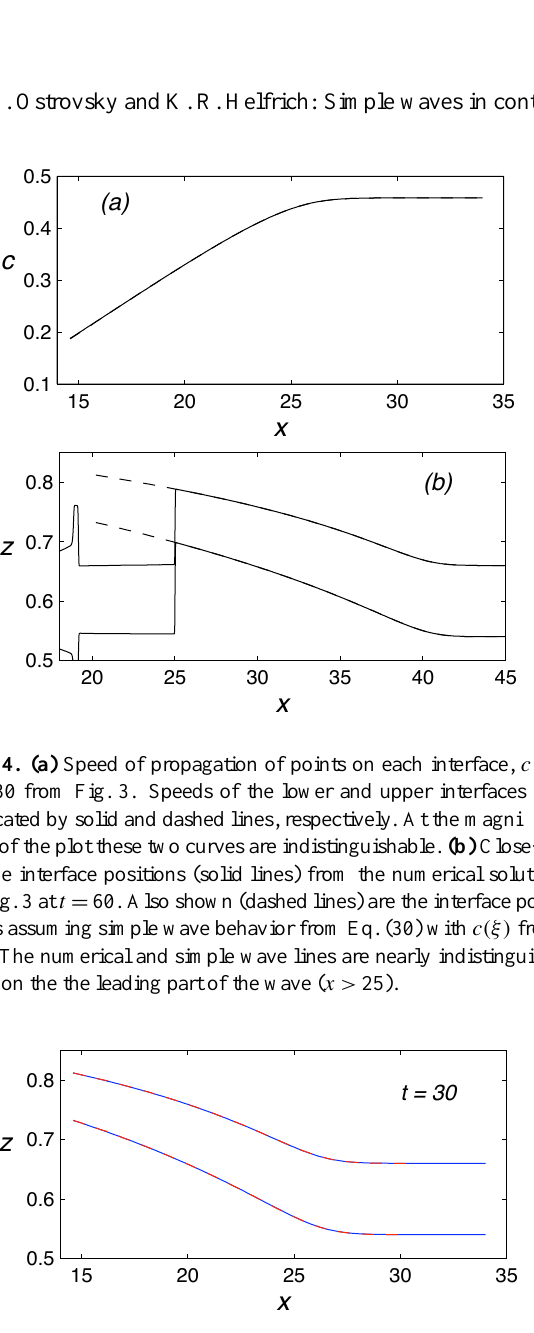
Fig. 5. Interface positions at t = 30 from the numerical solution in Fig. 3 (blue lines) and the solution of the layered simple wave Eqs. (31) and (32) (red dashed lines).